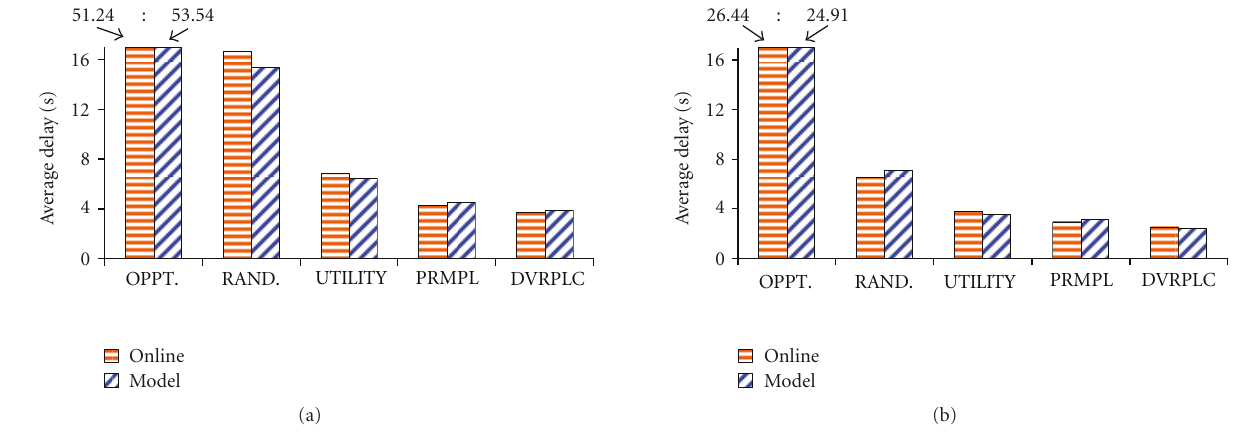
Figure 15: On-body packet delay for (a) sensor placement P1 and (b) sensor placement